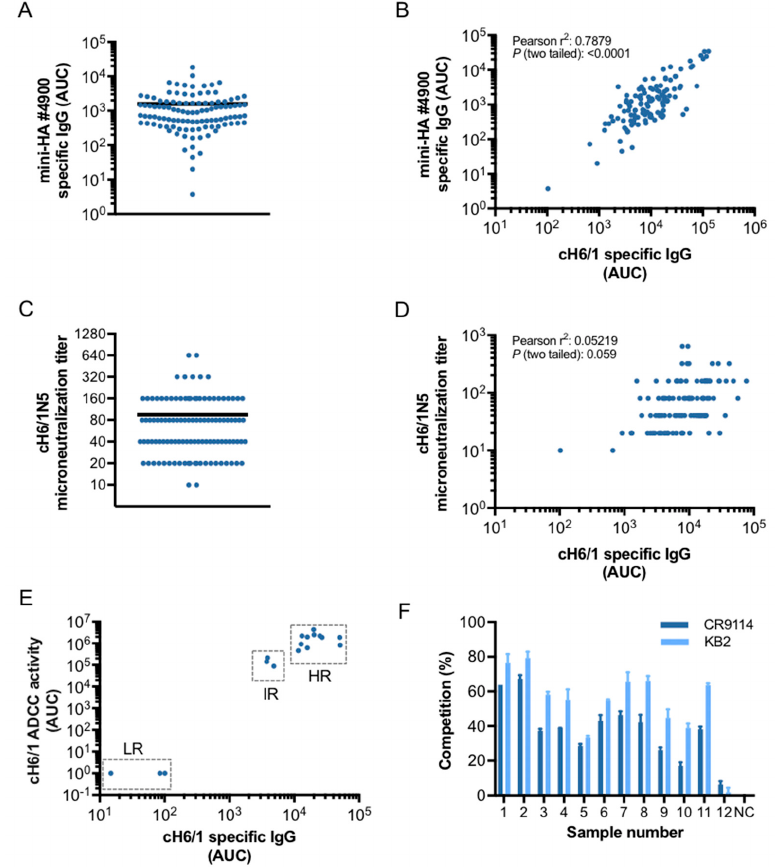
Figure 3. Characterizationofstalk-specificantibodiescontainedinhumanserumsamples. Humanserum samples ( n = 110) were screened for stalk-specific antibodies using a #4900 mini HA-based ELISA ( A ). The correlation between cH6 / 1-specific IgG and #4900 mini HA-specific IgG antibody levels is shown ( B ). Serum samples ( n = 110) were subjected to a cH6 / 1N5-based neutralization assay. Microneutralization titers obtained are presented ( C ). The correlation between cH6 / 1-specific IgG and microneutralization titers